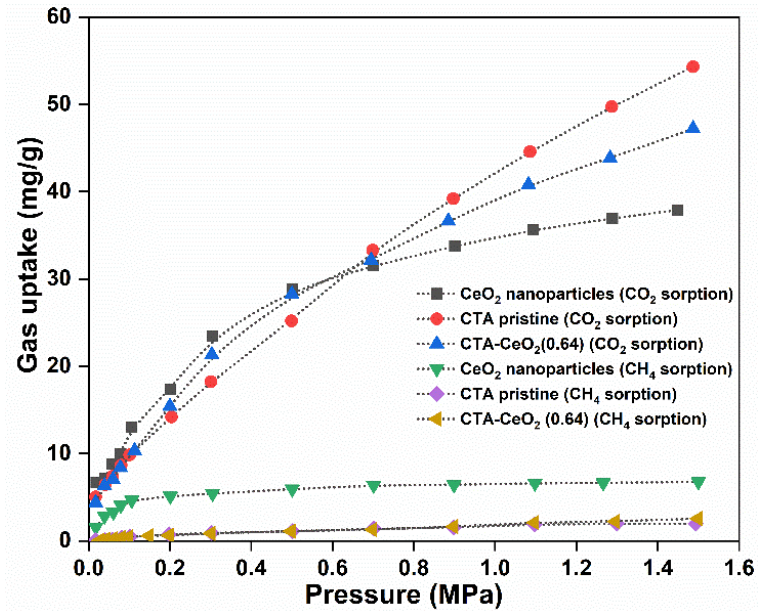
Figure 11. CO 2 and CH 4 gas sorption isotherms of CeO 2 nanoparticles, pristine CTA and CTA-CeO 2 MMMs.